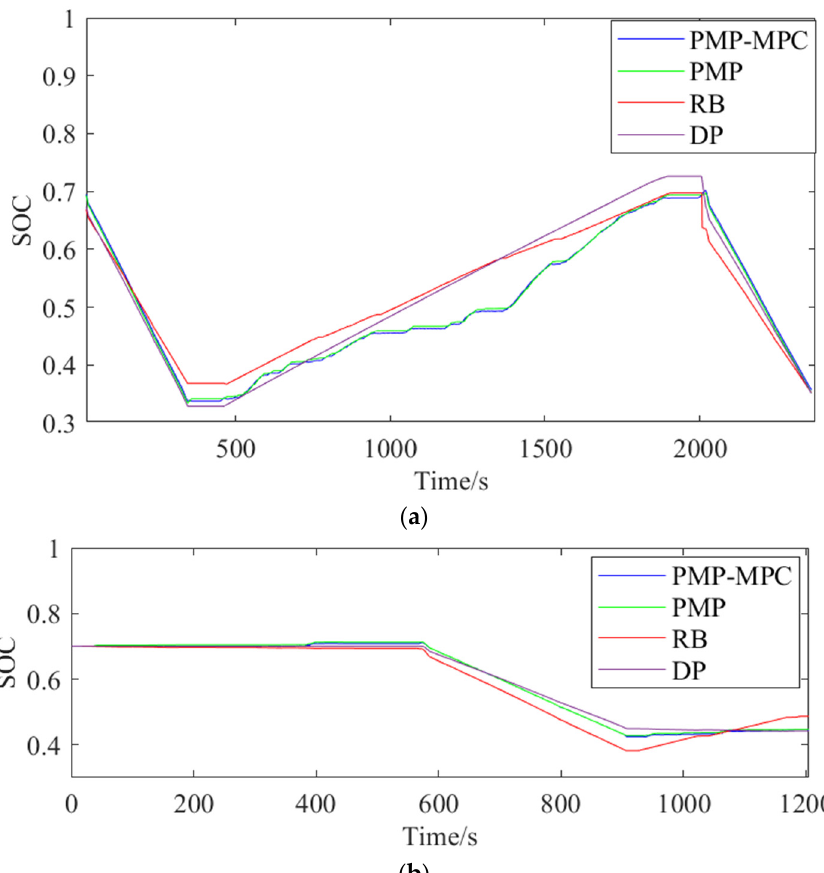
Figure 14. SOC profiles of different approaches. ( a ) SOC profiles of different approaches in driving cycle A. ( b ) SOC profiles of different approaches in driving cycle B. (Prediction horizon = 5 s for PMP-MPC).